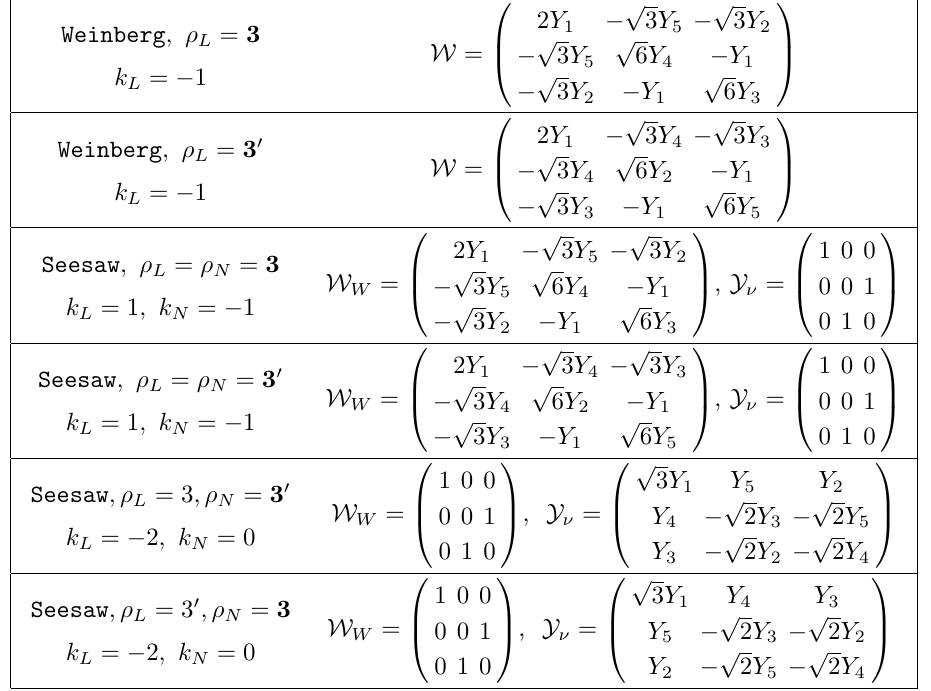
Table 4 . Relevant matrices in the neutrino sector of the superpotential in (cid:0) 5